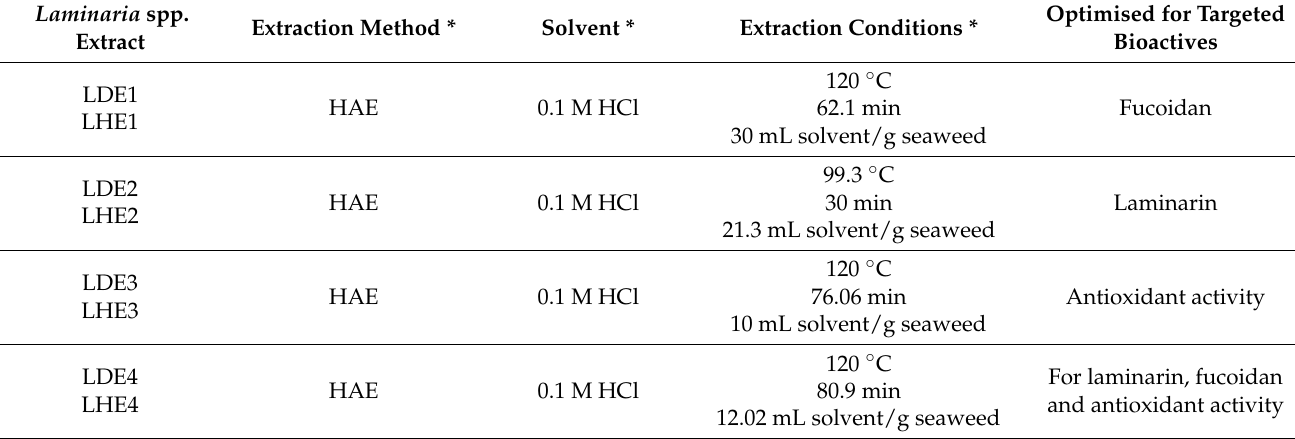
Table 1. Extraction conditions employed to obtain the different L. digitata and L. hyperborea extracts. Laminaria